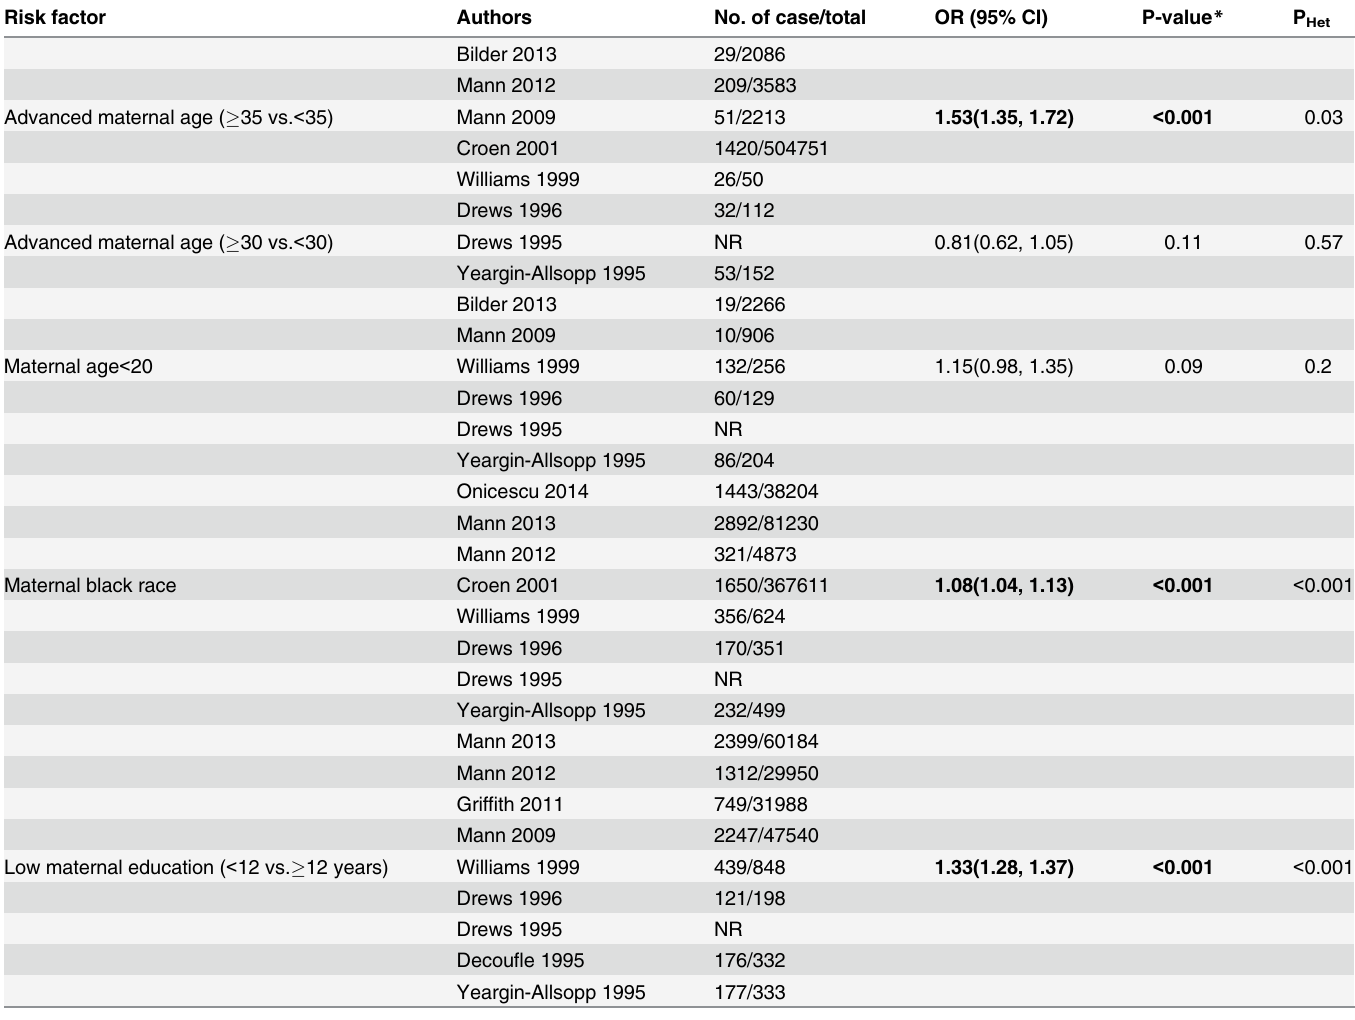
Table 2. Meta-analysis of prenatal risk factors for